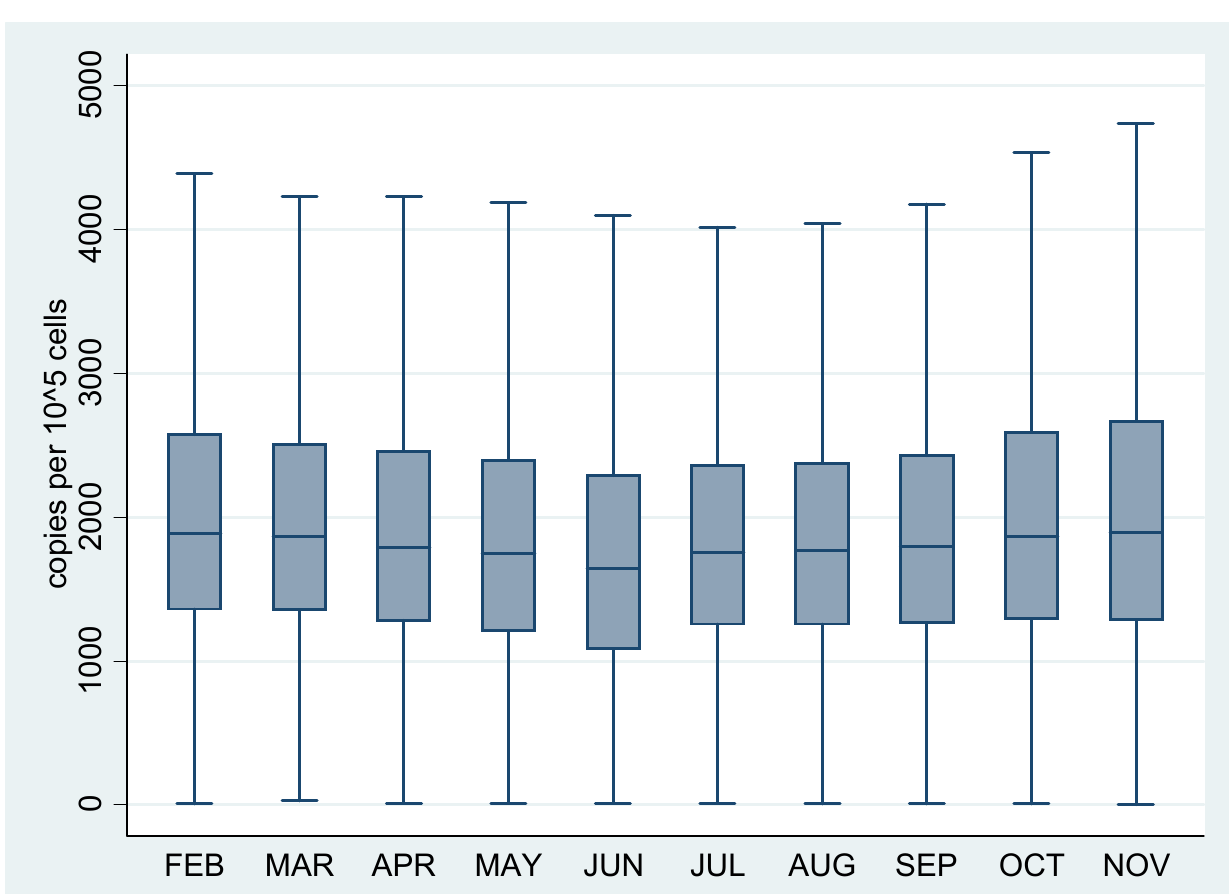
Figure 2. Boxplot of TREC values for all samples analyzed between February 2020 and November 2020 stratified by month. TREC values in copies per 10 5 cells. Boxes represent median and interquartile range.